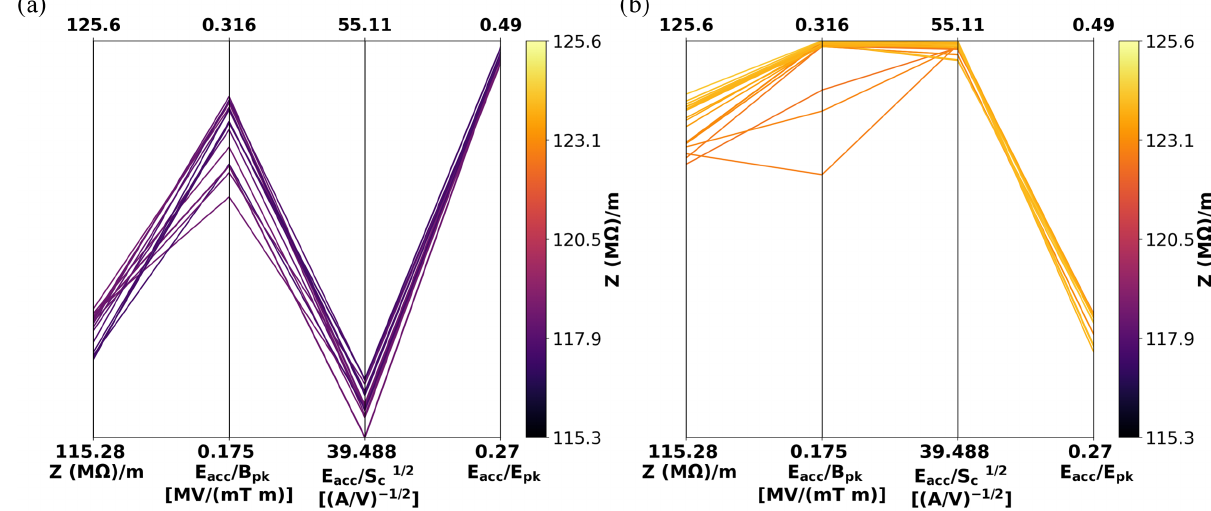
p ffiffiffiffiffi =E =E S ) and S2 (low )] c pk acc acc ffiffiffiffiffi p S =E ), S2 (high Z ), and p ffiffiffiffiffi c acc =E S )]. Field shown is the c acc